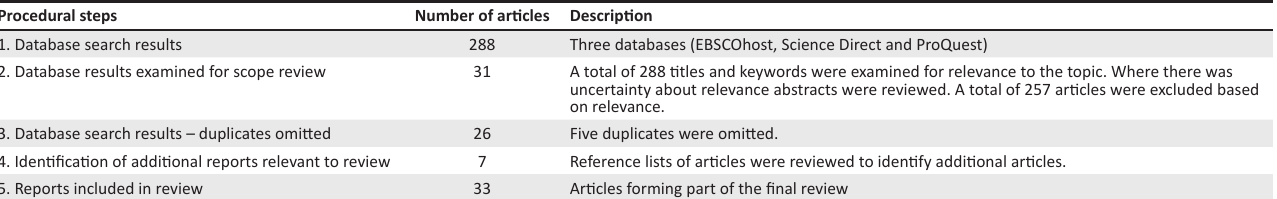
TABLE 1: Description of the search results identifying articles for the review.